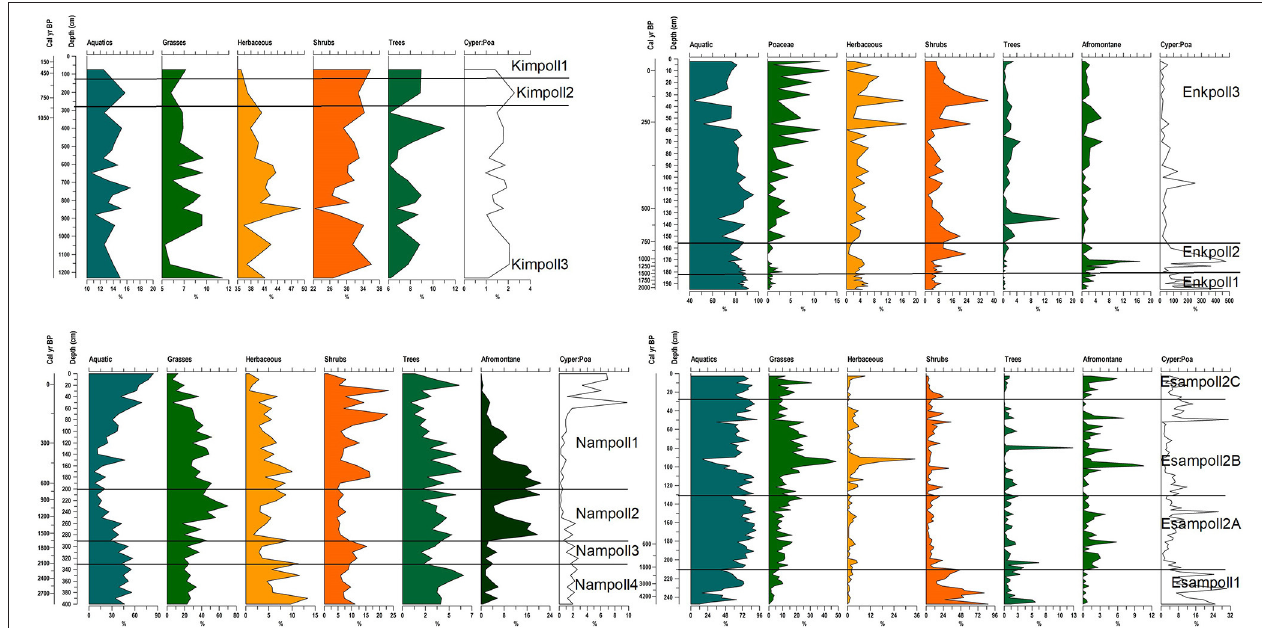
FIGURE 3 | Pollen taxa identified from Enkongu, Namelok, Kimana and Esambu sediment records since the mid Holocene classified into vegetation types (aquatic, grasses, herbaceous, shrubs, trees, Afromontane and the Cyperaceae:Poaceae ratio). Table S2 lists all the pollen taxa and can be referred to for taxa in each